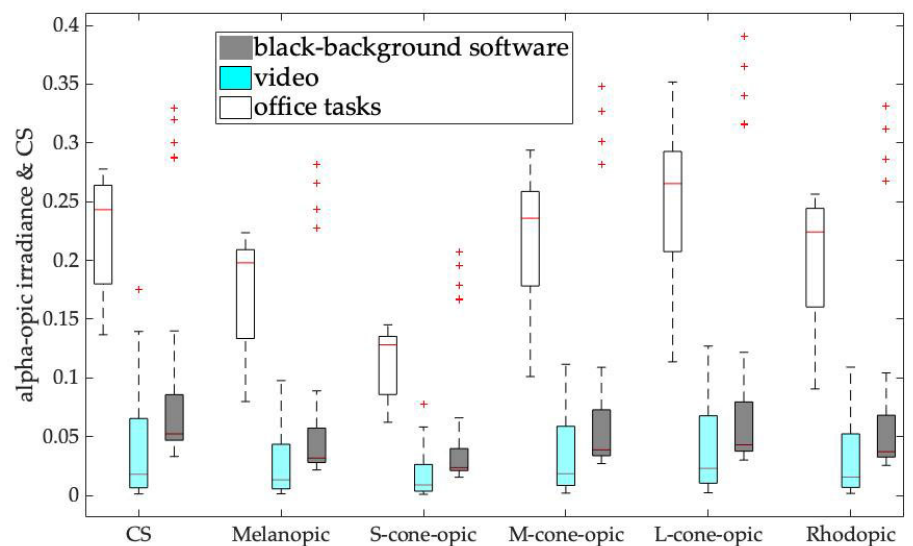
Figure 2. The circadian stimulus ( CS ) and α -opic irradiance caused by the light from different displays when different computer tasks were performed by users. The red horizontal lines that divide the boxes into two parts mark the median (middle quartile). The boxes represent the inter- quartile range (the middle 50%) and the upper and lower whiskers show the highest and lowest non-outliers. The red crosses outside the boxes show the outliers.